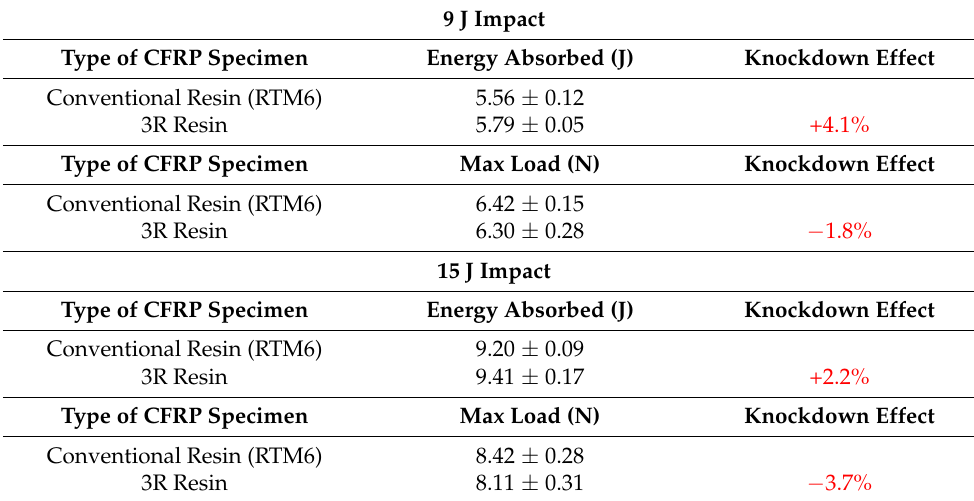
Table 1. Knockdown effect values of 9 and 15 J impacts.